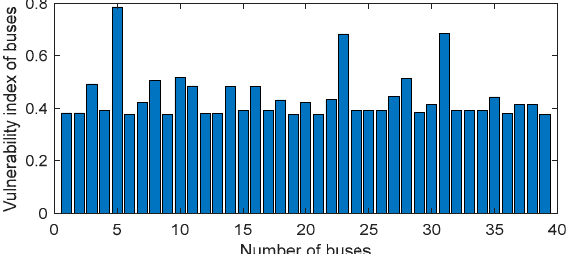
Figure 12. The vulnerability index of the Yuan'an substation.